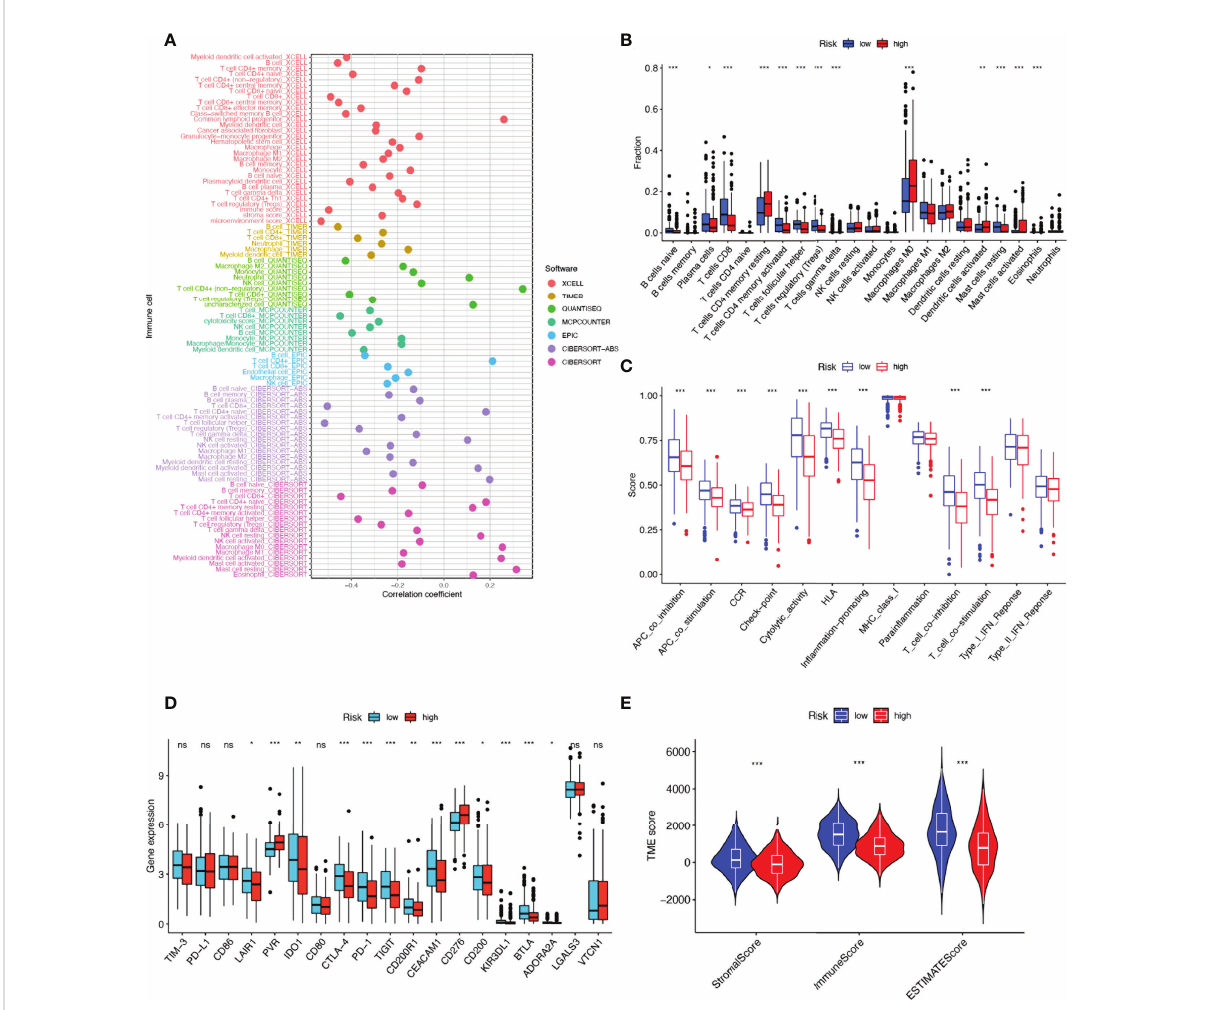
FIGURE 7 17-NRGs risk score predicts tumor microenvironment and immune cell in fi ltration. (A) Immune cell bubble map. (B) Differences in immune cell in fi ltration between high and low-risk groups. (C) Immune function ssGSEA scores between high and low-risk groups. (D) Immune checkpoint differences between high- and low-risk groups. (E) TME component analysis. * P < 0.05, ** P < 0.01, *** P < 0.001, ns ≥